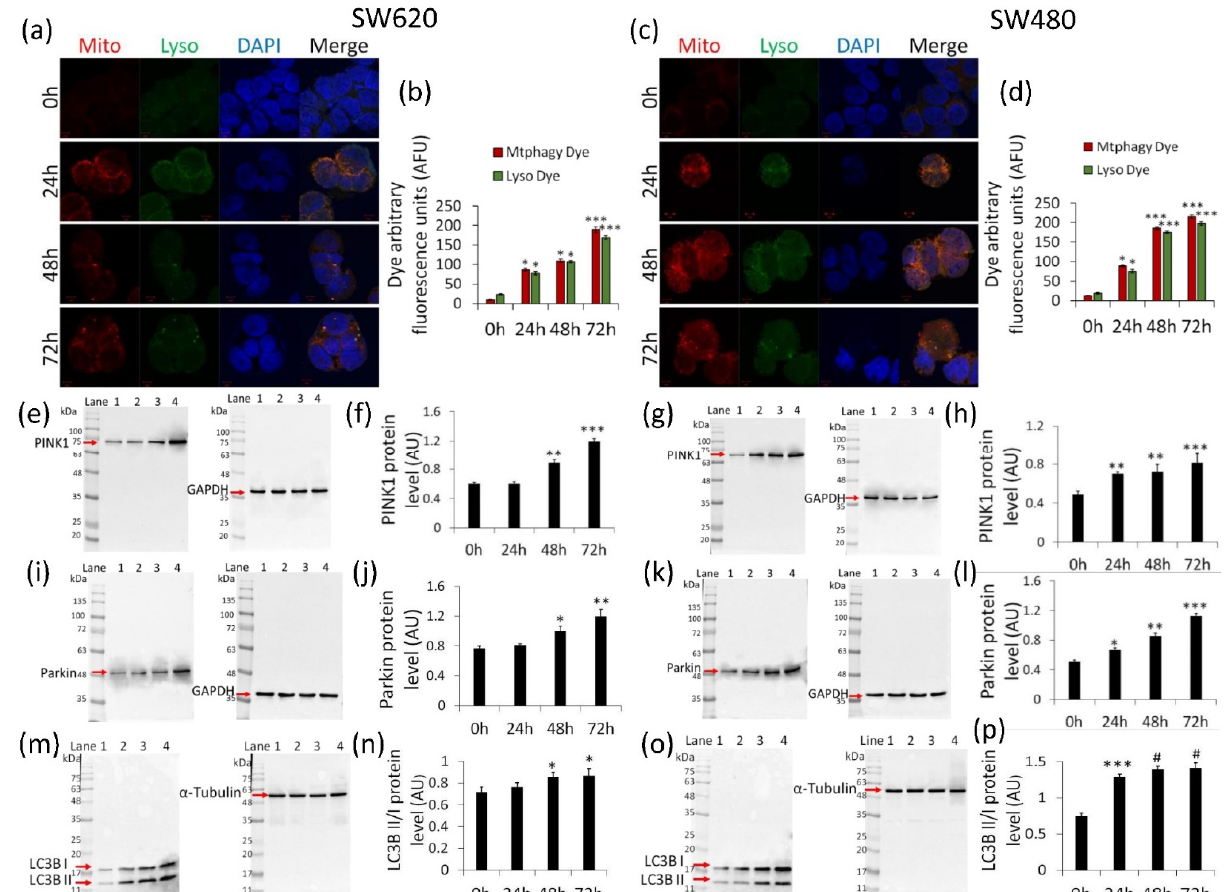
Figure 5. δ VB effects on mitophagy. Representative confocal images of mitophagy (red) and lysosome (green) dyes and analysis of ( a , b ) SW620 and ( c , d ) SW480 cells treated with δ VB (1.5 mM) for 24, 48 and 72 h. Nuclei were counterstained with DAPI (blue). Fluorescence intensity analysis was performed by ImageJ software and expressed as arbitrary fluorescence units (AFU) of dye signal ± SD of n = 3 replicates. Scale bar: 5 μ m. Representative immunoblotting images and analyses of ( e – h ) PINK1, ( i – l ) Parkin and ( m – p ) LC3B protein levels in SW620 and SW480 cells. Lane 1 = 0 h; lane 2 = 24 h; lane 3 = 48 h; lane 4 = 72 h. Before lane 1, molecular weight markers (G266, Applied Biological Materials Inc., Richmond, BC, Canada). Protein expression was calculated, after normalization with internal control ( α -tubulin or GAPDH), with ImageJ software and results expressed as arbitrary units (AU). * p < 0.05 vs. Ctr; ** p < 0.01 vs. Ctr; *** p < 0.001 vs. Ctr; # p < 0.0001 vs. Ctr.